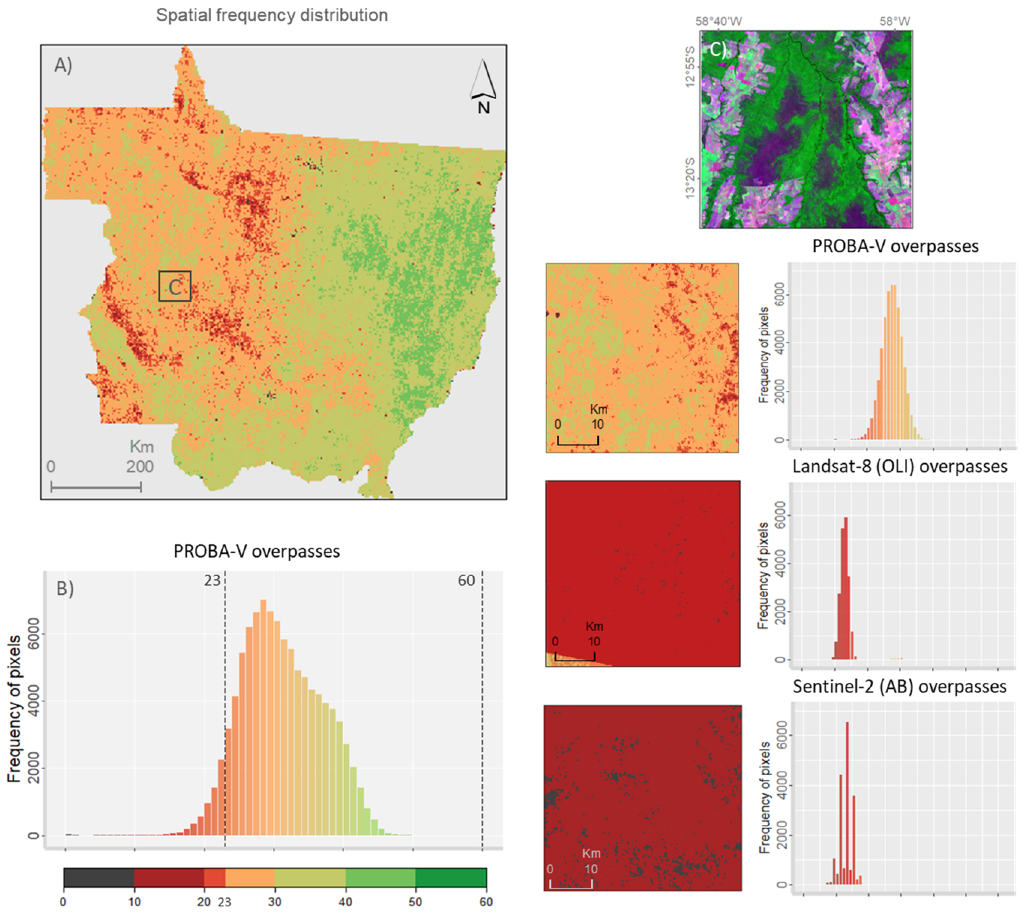
Figure 9. ( A ) Spatial distribution of cloud-free and cloud shadow-free pixels in an annual PROBA-V 100-m composite. ( B ) Histogram of the frequencies of cloud-free and cloud shadow-free pixels in Mato Grosso state. Vertical, dashed lines represent a hypothetical maximum number of pixels in the Landsat-8 OLI and Sentinel-2 collection. ( C ) Enlargement of a cropland-dominated region located in the Campo Novo do Parecis municipality. In the upper right, the red-NIR-SWIR color composite of PROBA-V. In the center right, the spatial distribution of data availability of a year of PROBA-V images and Sentinel-2 (bottom right).